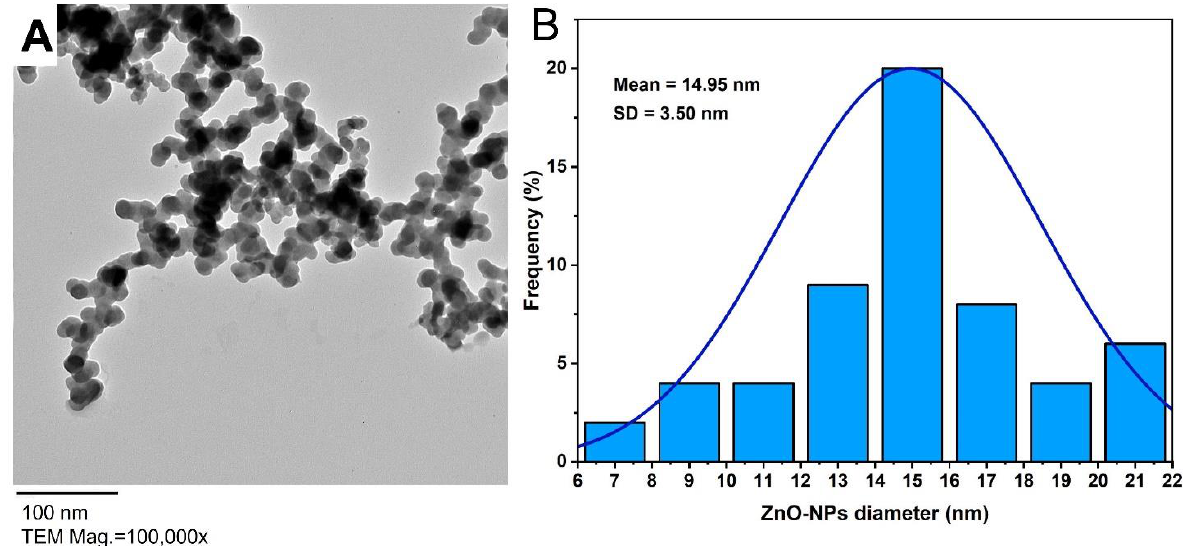
Figure 3. ( A ) is the TEM image for ZnO-NPs synthesized by bacterial strain P. aeruginosa NMJ15, ( B ) is the histogram that showed ZnO-NPs’ size distribution based on the TEM image.